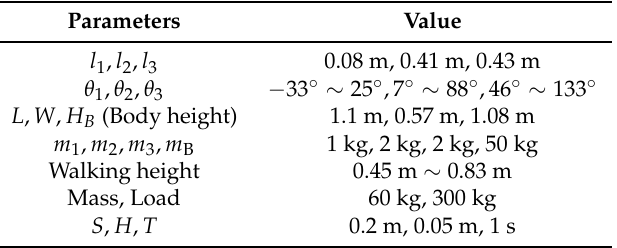
Table 1. System and simulation parameters.